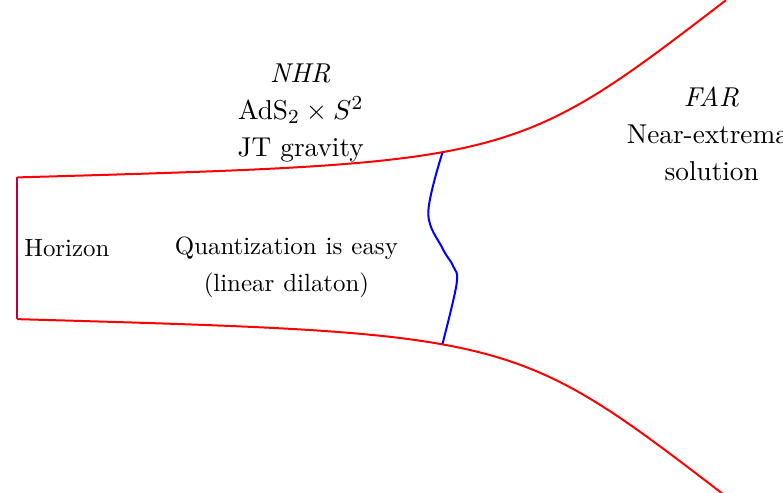
Figure 3. A cartoon of the near-horizon region (NHR) and the far-away region (FAR) separated by a boundary at which the boundary term of JT gravity will need to be evaluated. In the throat quantization is easy and necessary to account for at low temperatures. In the FAR quantization is hard but quantum corrections are